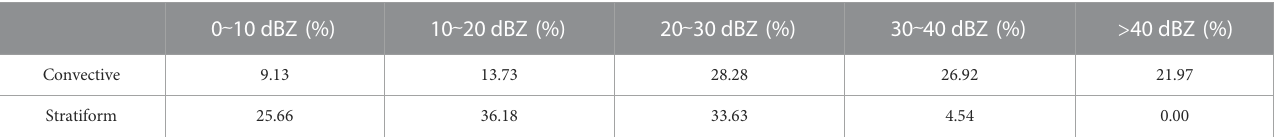
TABLE 3 Percentage of re fl ectivity in the convective and stratiform